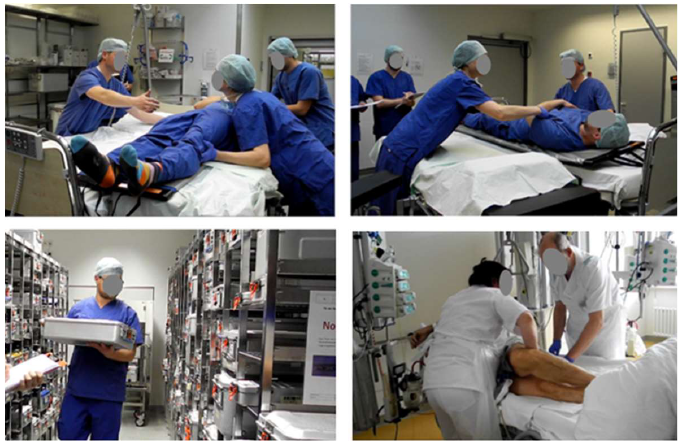
Figure 2. Typical manual handling scenarios identified and investigated in a preliminary workshop with hospital personal. Upper left: manual patient transfer in the post-op waiting room, upper right: manual patient transfer in the pre-op waiting room, lower left: manual handling in the logistics operation area, lower right: manual patient transfer in the intensive care unit (Diakonie-Klinikum Stuttgart, photos taken on 28 March 2019).